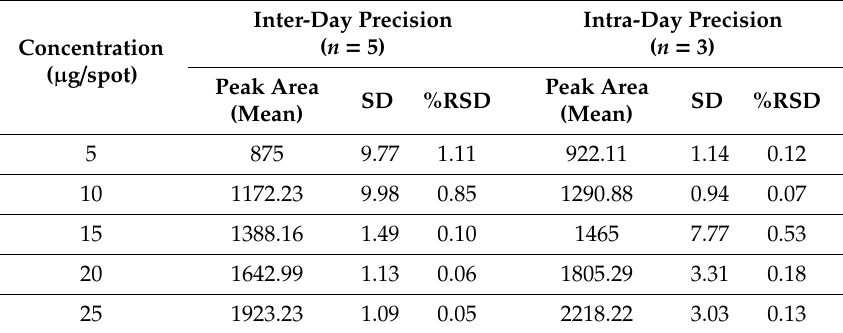
Table 5. Data for inter-day and intra-day precision for